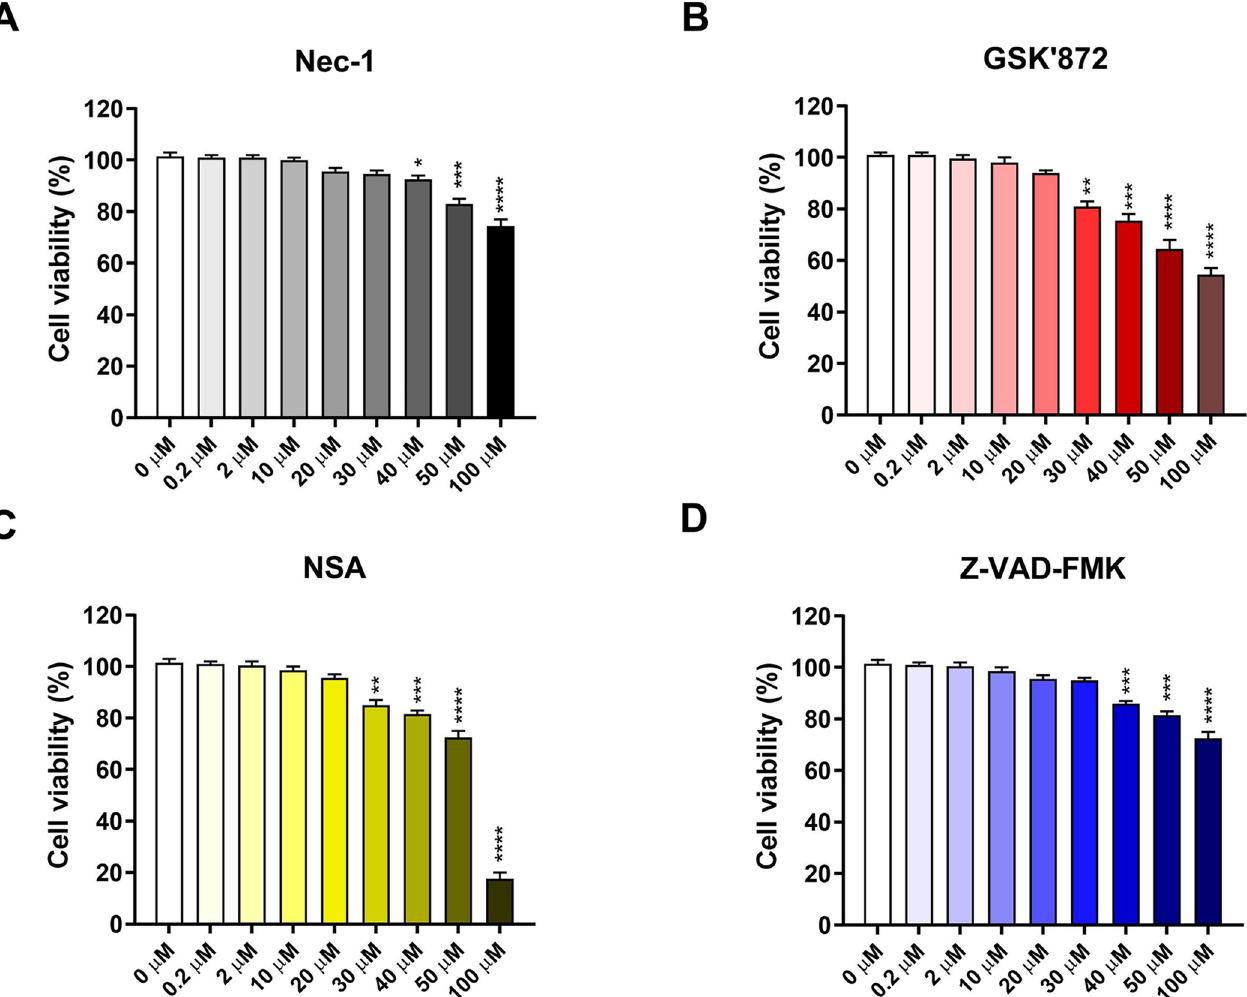
Fig 5. Determination of the cytotoxicity of each necroptosis and apoptosis chemical by the MTT assay. (A-D) LLC-PK cells grown in 96-well plates in triplicate were treated with various concentrations of the RIPK1 inhibitor Nec-1, RIPK3 inhibitor GSK’872, MLKL inhibitor NSA, and pan-caspase inhibitor Z-VAD-FMK or left mock-treated and incubated for 24 h at 37˚C. Cell viability was measured at OD 570 using an ELISA reader. The results represent the means ± standard error from two independent experiments. Differences were evaluated using one - way ANOVA. � p < 0.05; �� p < 0.01; ��� p < 0.001; ���� p <